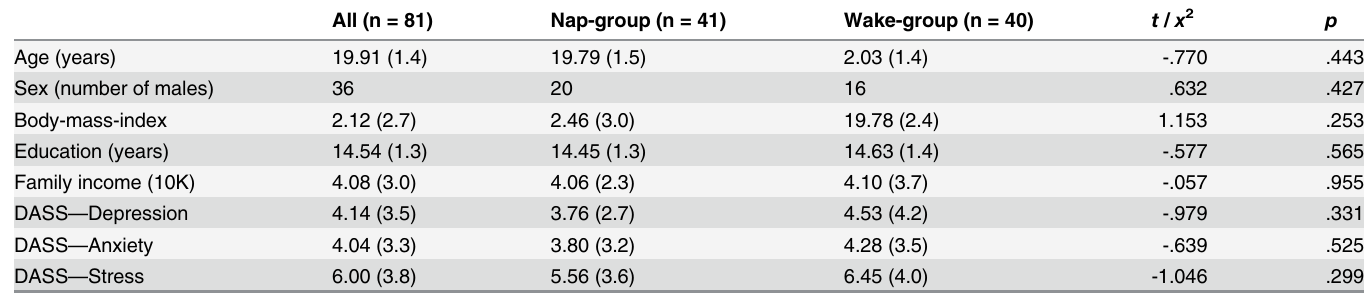
Table 1. Demographics of the sample.